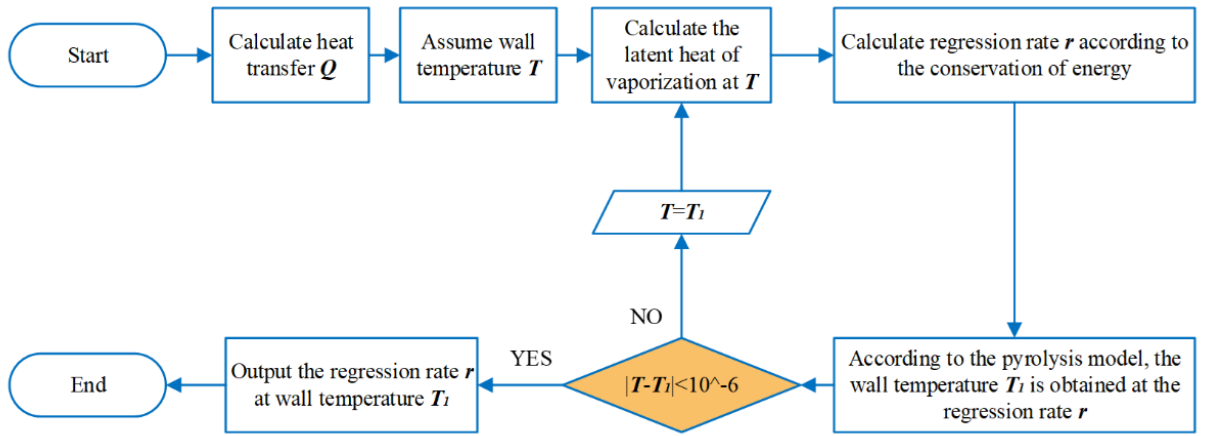
Figure 5. The temperature boundary and regression rate calculation process.